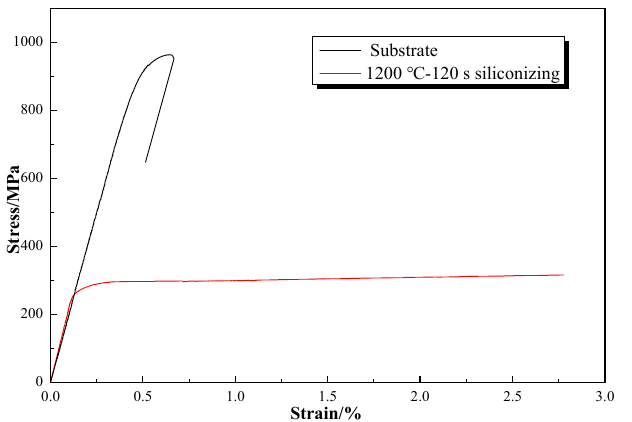
Figure 7. Tensile stress—strain curve of silicon steel and matrix after silicon permeation of the material after siliconization at 1200 °C for 120 s.